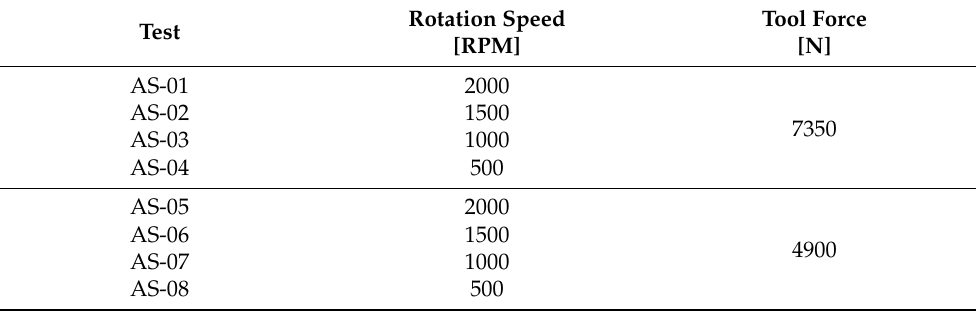
Table 3. Process